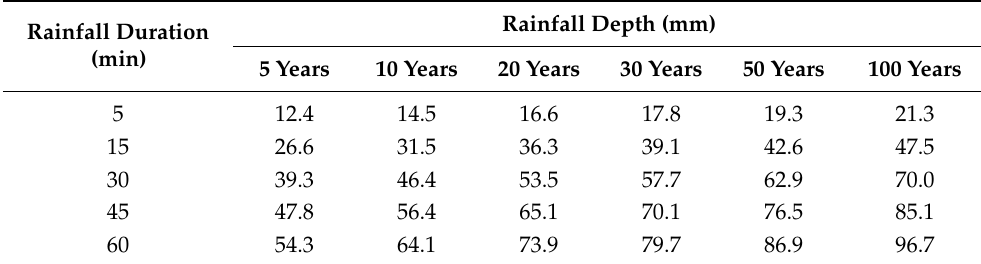
Table 4. Rainfall depth of design duration in different return periods